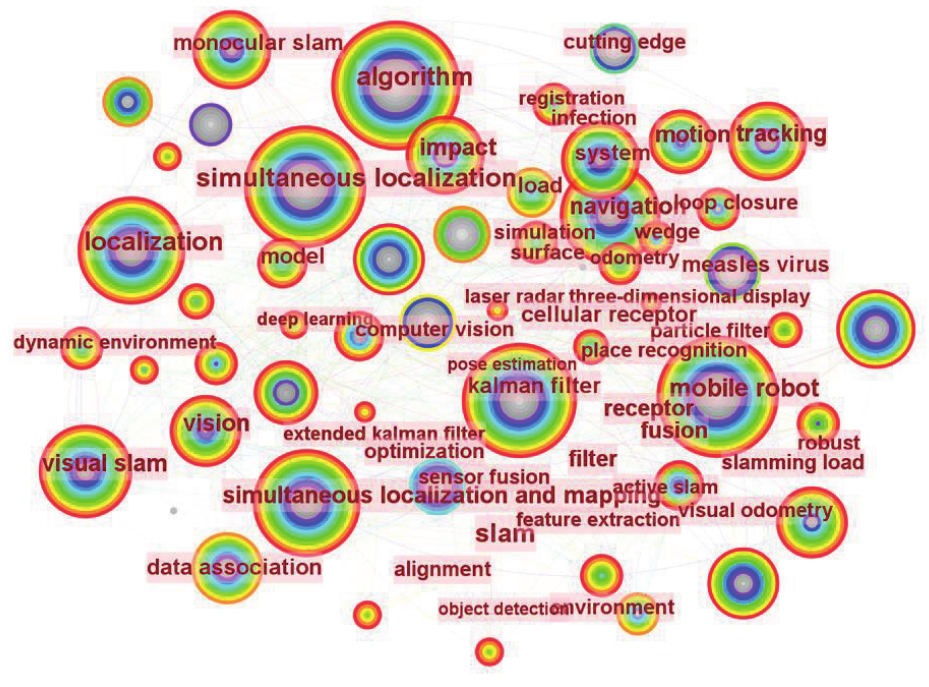
Figure 7. Hot words in the field of mobile